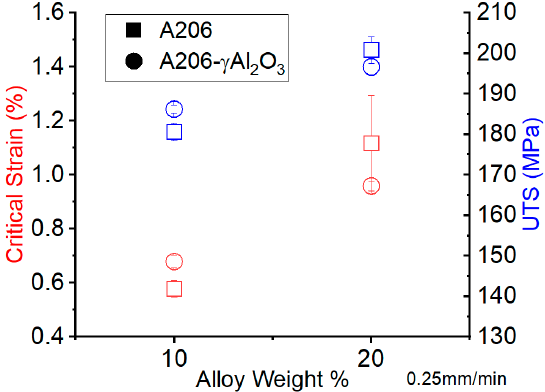
Figure 3. Measured critical strain and UTS at 0.250 mm/min strain rate.